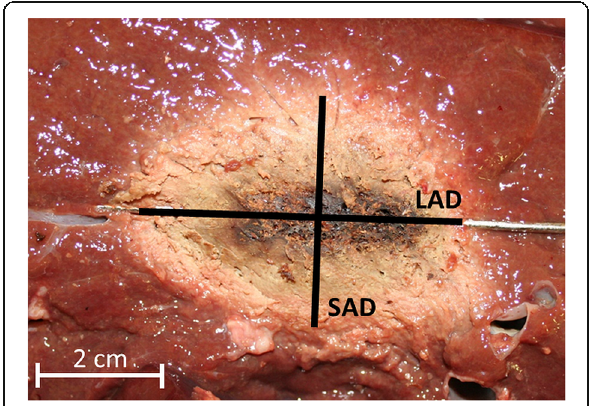
Fig. 1 Cross-section of an ablation zone after 15 min ablation at 120 W. The long axis diameter (LAD) and short-axis diameter (SAD) are